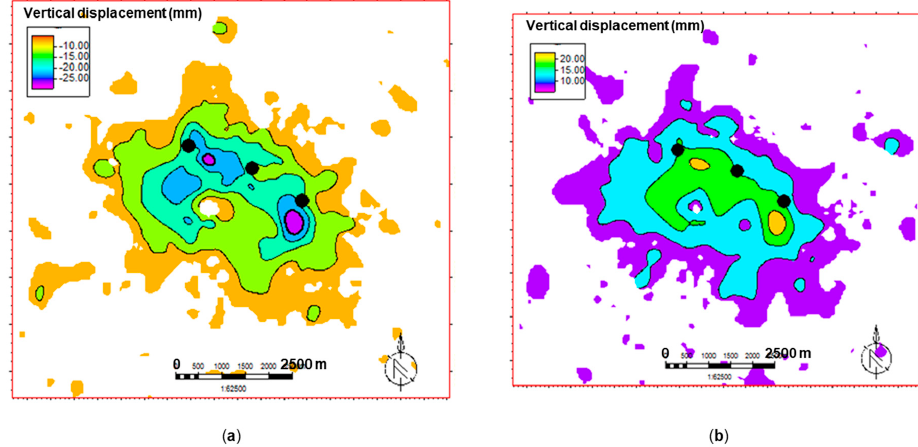
Figure 10. Areal extension of the ground surface cyclically affected by UGS activities from InSAR data analysis: ( a ) vertical displacement within a production cycle and ( b ) an injection cycle.